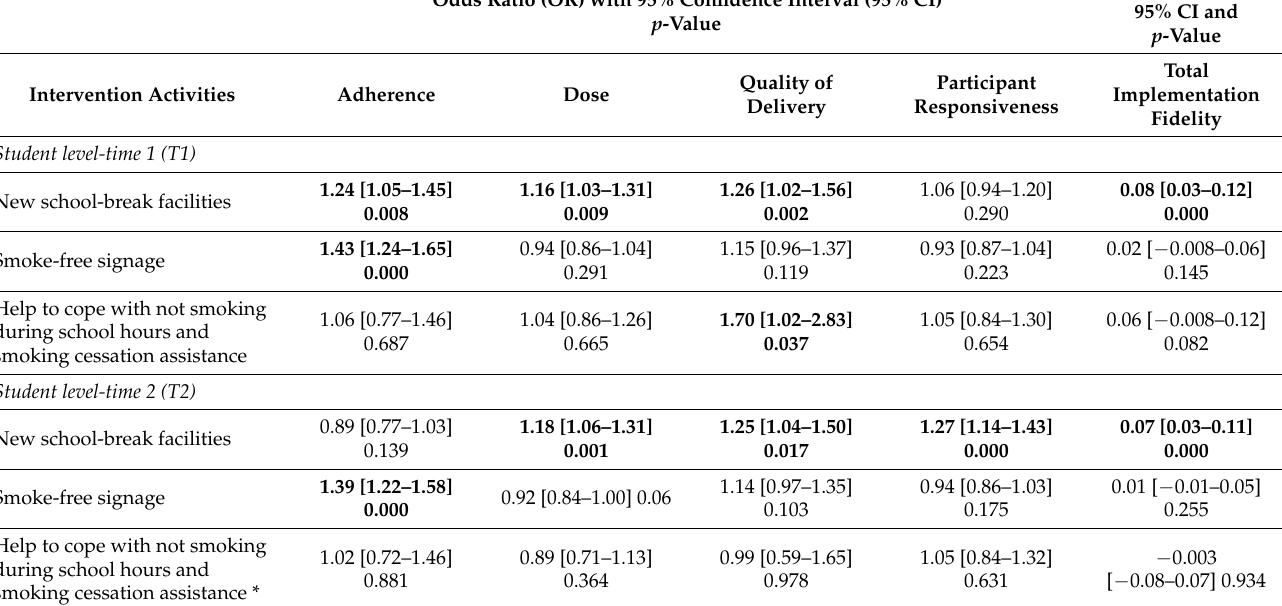
Table 7. Student level associations between intervention activities and implementation fidelity of the smoke-free school hours policy, across T1 and T2, adjusted for age, sex, smoking status, educational level enrolled and main subject area. Odds Ratio (OR) with 95% Confidence Interval (95% CI) p